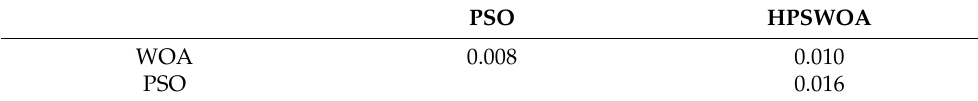
Figure 4. Scatter plot of the average computational time obtained from Table 6. Table 7. Statistical test results for the average computational time obtained from Table 6.